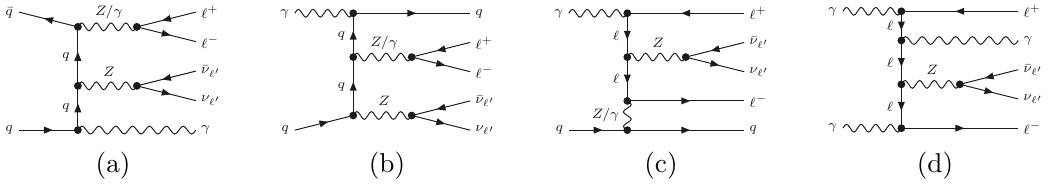
Figure 8 . Sample of real emission diagrams contributing to 2 ‘ 2 (cid:23) (cid:12)nal states only in the same- (cid:13)avour (wrt. the charged leptons) case in the quark-antiquark channel (a), the (anti-)quark-photon channel (b,c) and the photon-photon channel